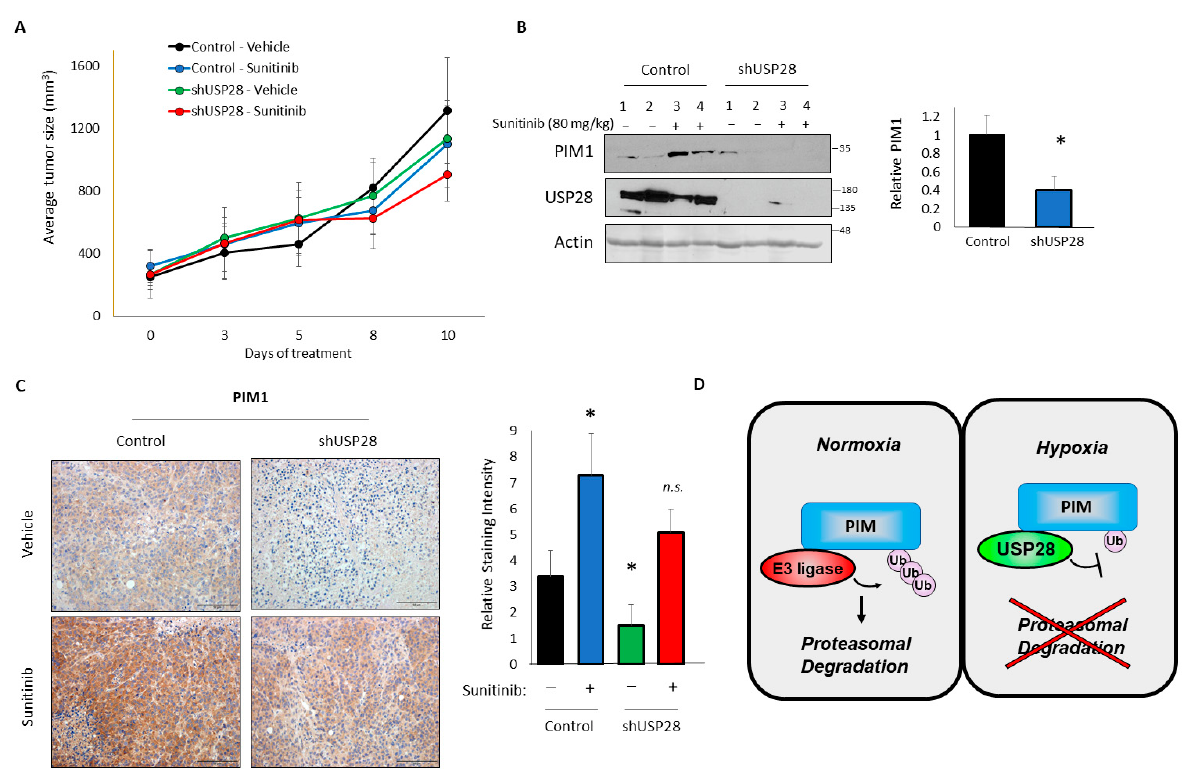
Figure 5. Upregulation of PIM1 in response to anti-angiogenic agents requires USP28. Mice were injected subcutaneously with PC3-LN4 control or USP28-knockdown cells and treated with a vehicle or sunitinib. ( A ) Growth curve of tumors in the four groups (n = 8). ( B ) Tumors were harvested, and lysates were used for western blotting. Right, quantification. ( C ) Representative immunohisto- chemical staining of PIM1 in tumors from the four groups (scale bar = 50 µ M). Right, quantification. ( D ) Model. * p <